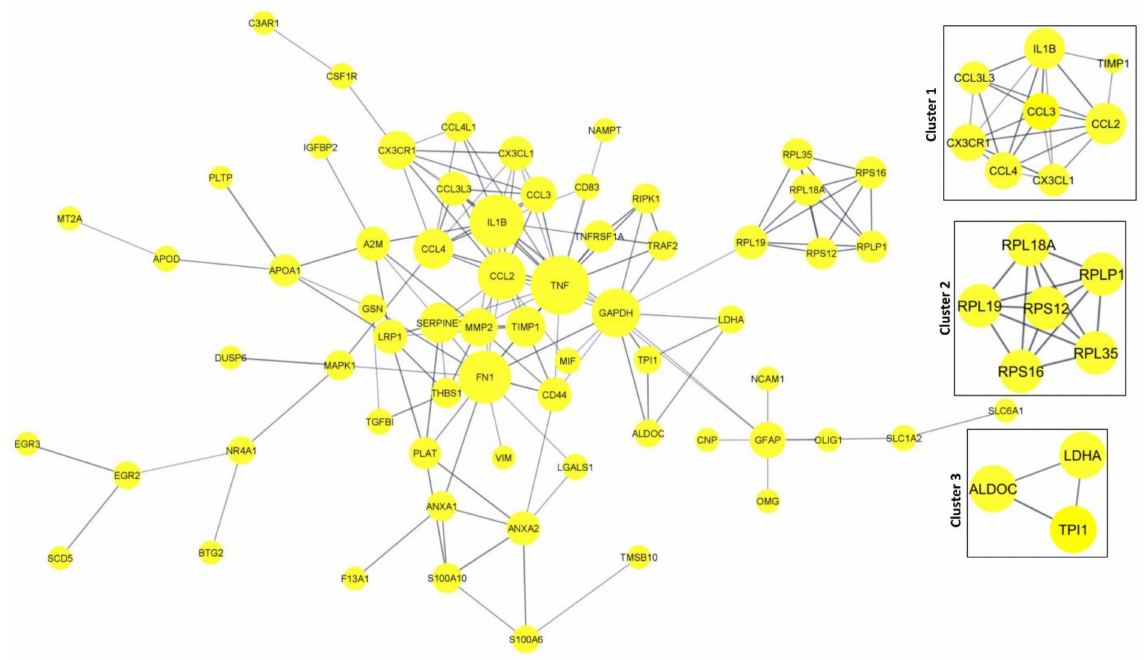
Figure 8. PPI network for the significant DEGs. Cluster and Hub gene screening from the network were performed using MCODE of